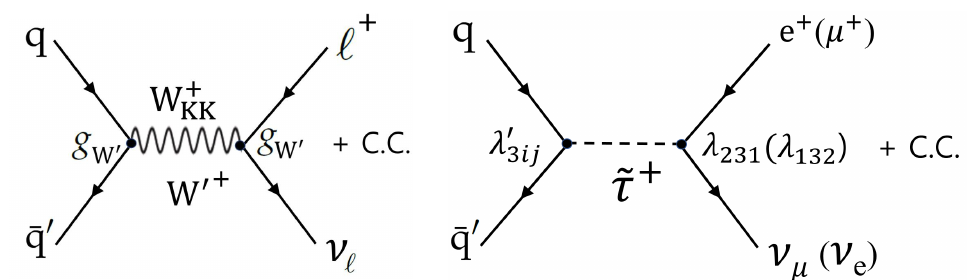
Figure 1 . Feynman diagram for the production and decay of a new heavy boson, an SSM W 0 or a Kaluza-Klein excitation mode of W ( W ) (left). The coupling strength, g KK In RPV SUSY, a t slepton ( ) could also act as a mediator (right) with the corresponding coupling e t strength, λ , for the decay. This coupling strength is allowed to be different between the two final states, denoted by λ and λ for the electron and muon final states, respectively. Here, C.C. 231 132 stands for charge